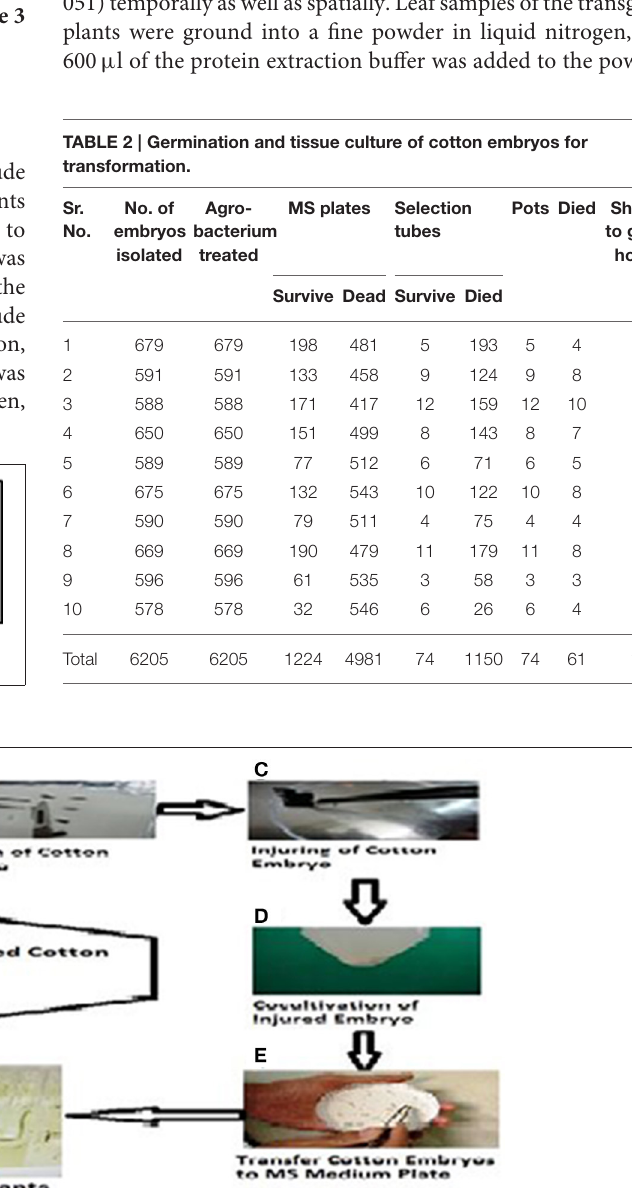
Frontiers in Plant Science |